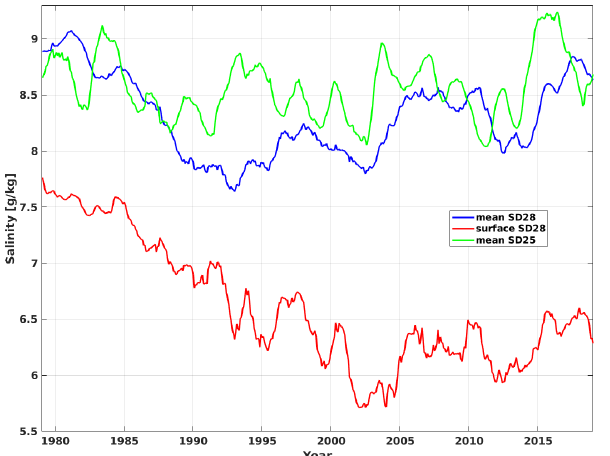
Figure 4. Mean salinity of Subdivision 28 (SD 28, eastern Gotland Basin) (blue) and surface salinity of SD 28 (red). For comparison, the mean salinity of SD 25 (Bornholm Basin) (green) is shown for the period 1979–2018. All series are 12-month running